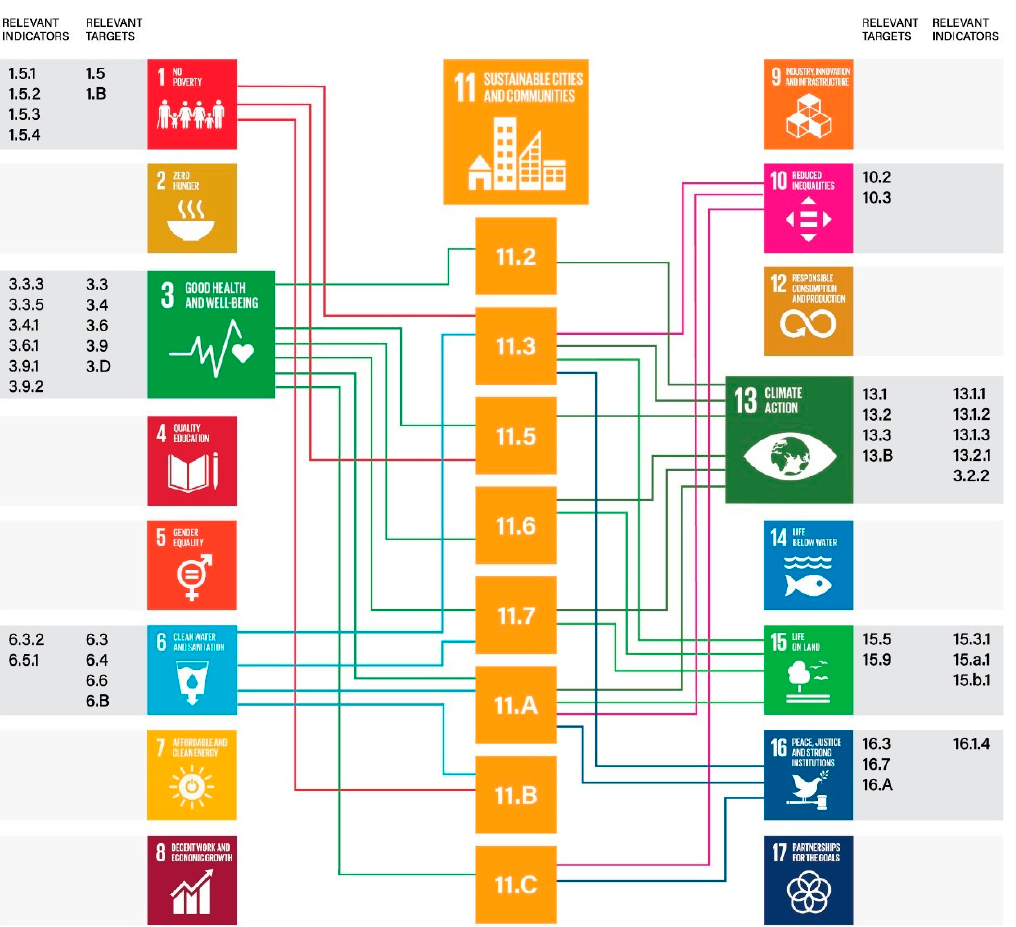
Figure 1. Sustainable development goals (SDGs), targets and indicators in connection with SDG 11. Adapted from: United Nations Human Settlement Program (UN-Habitat). SDG 11 Synthesis Report: Tracking Progress towards Inclusive, Safe, Resilient and Sustainable Cities and Human Settlements. 2018.